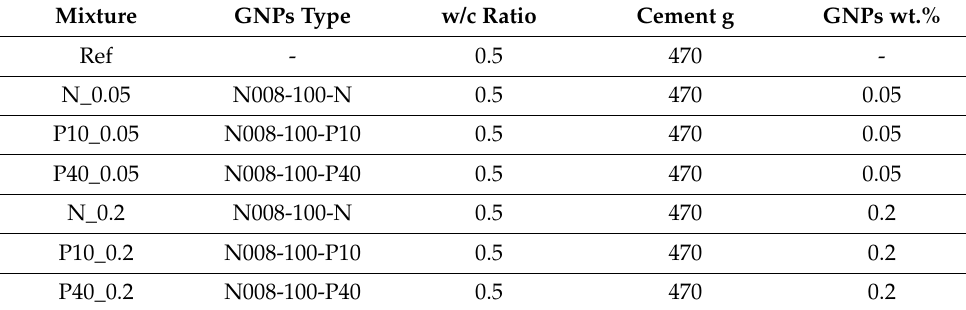
Figure 3. GNP–cement composite preparation. Table 3. Mix proportions for reference and GNP-composites.